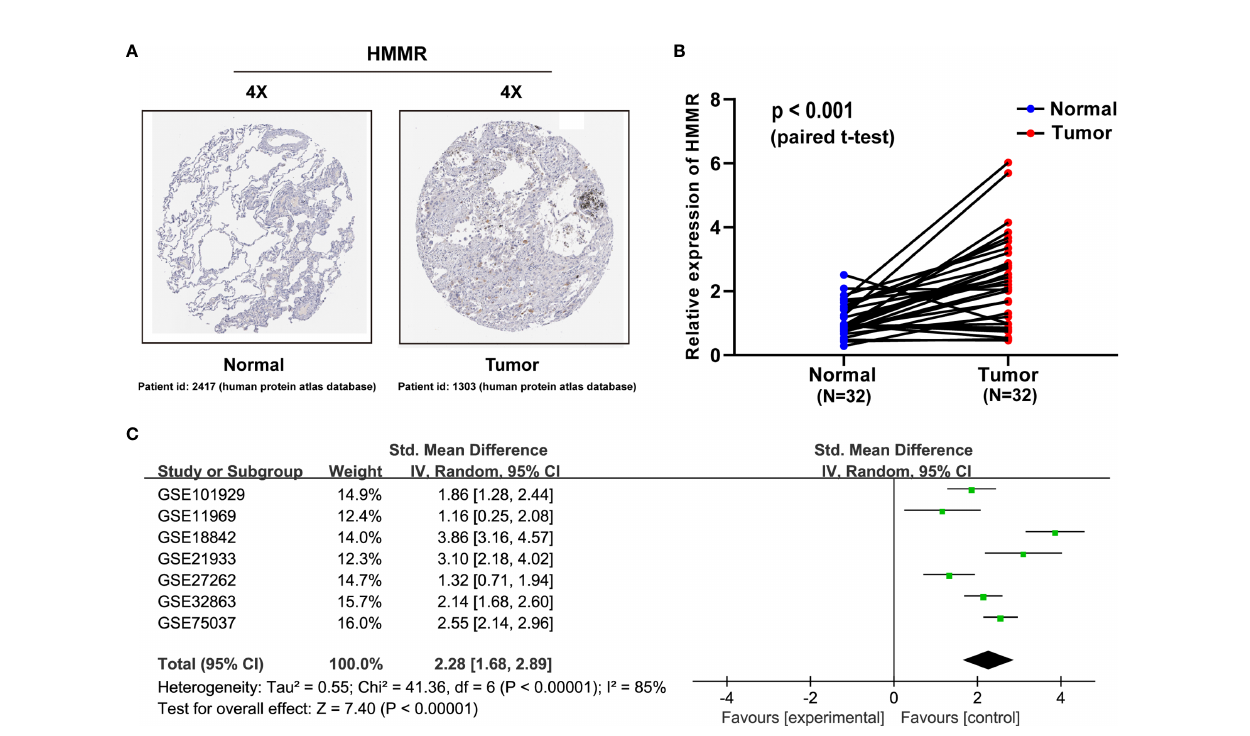
FIGURE 2 | HMMR is upregulated in LUAD patient specimens. (A) HMMR expression in normal lung tissues and LUAD specimens. Images were taken from the human protein atlas (http://www.proteinatlas.org) online database. (B) Expression of HMMR in 32 LUAD tissues and corresponding nontumor tissues were detected by qRT-PCR ( p < 0.001). (C) Forest plot of HMMR expression data from GEO microarrays. Gene Expression Omnibus (GEO), standard mean difference (SMD), con fi dence interval